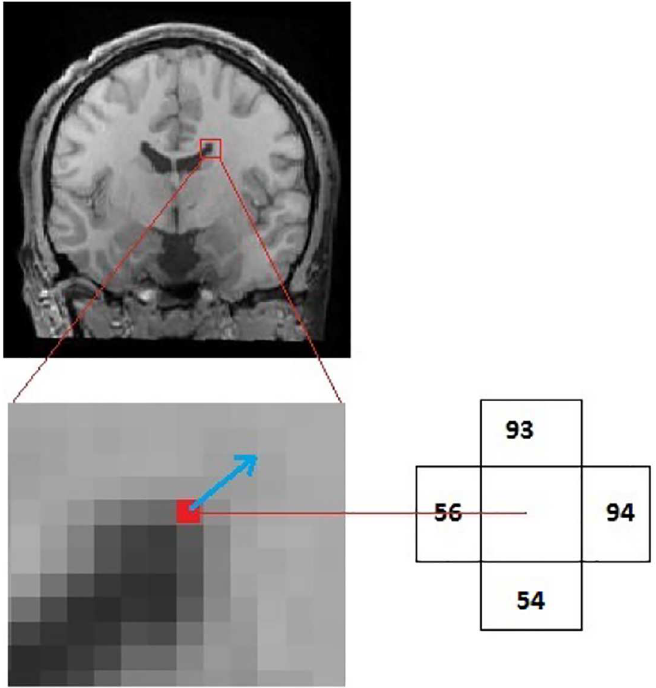
Fig 4. Gradient vector of a sample pixel. For illustration, we describethe 2D HOG feature computation process. Here, we consider a singlepixel, the one shown in red, whose neighbors have intensities 56, 93, 94, and 55. The blue arrow is the sample gradient, computedas describedbelow. (This figure is best viewedin